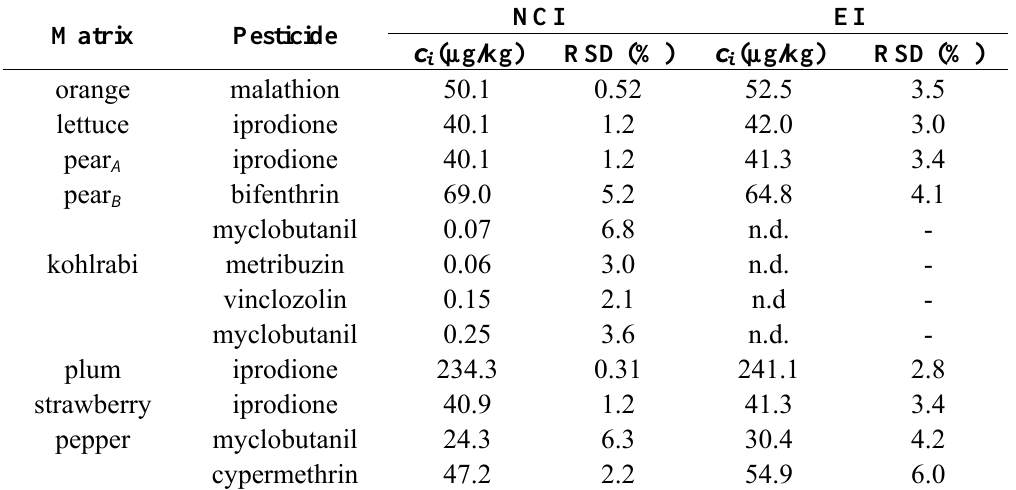
Table 6. Concentration c (µg/kg) of EDPs residues in real samples and repeatability of i measurements expressed as relative standard deviation RSD (%) of parallel extractions [50].